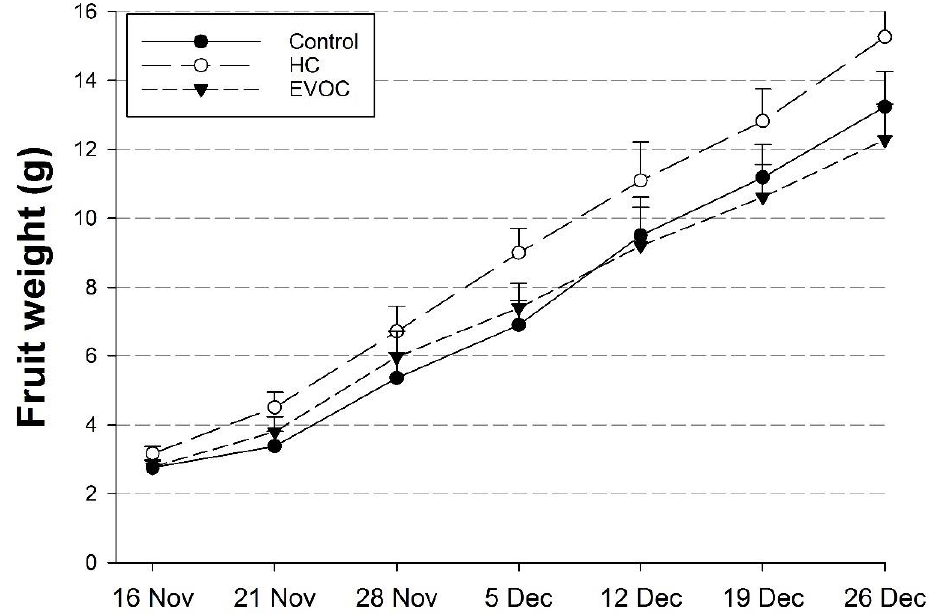
Figure 6. Increase in fruit weight of the sweet cherry cultivar ‘Lapins’ from straw stage to commercial harvest. Error bars are the least significant difference ( p < 0.05).